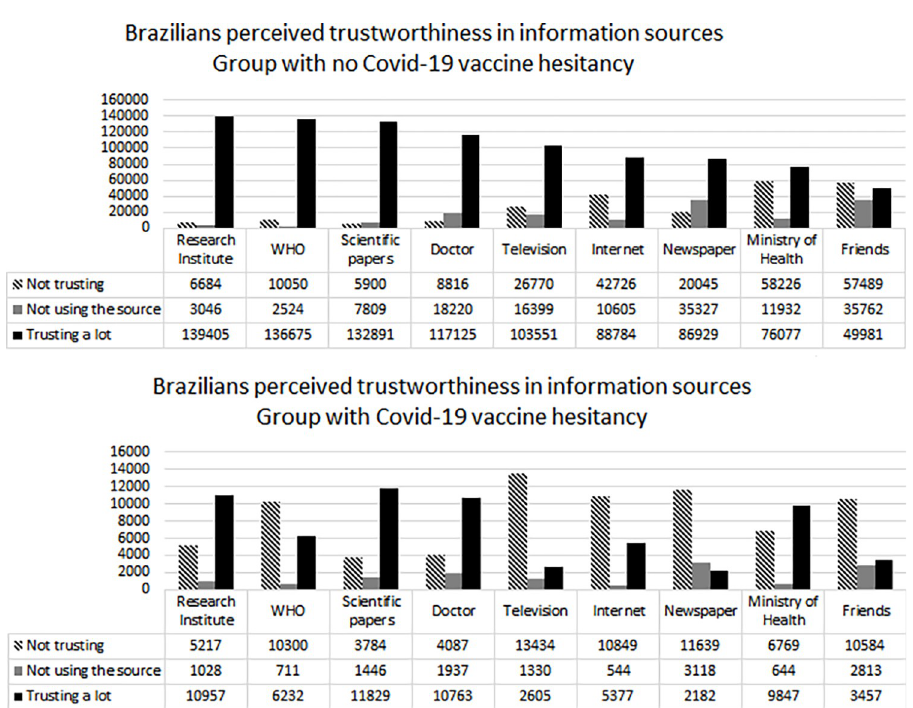
Fig 3. Brazilians perceived trustworthiness of sources of information about the vaccine for the prevention of COVID-19 according to vaccine hesitancy (n = 173,178, with 18,250 hesitant and 154,928 non-hesitant). Some participants did not report trustworthiness in some information